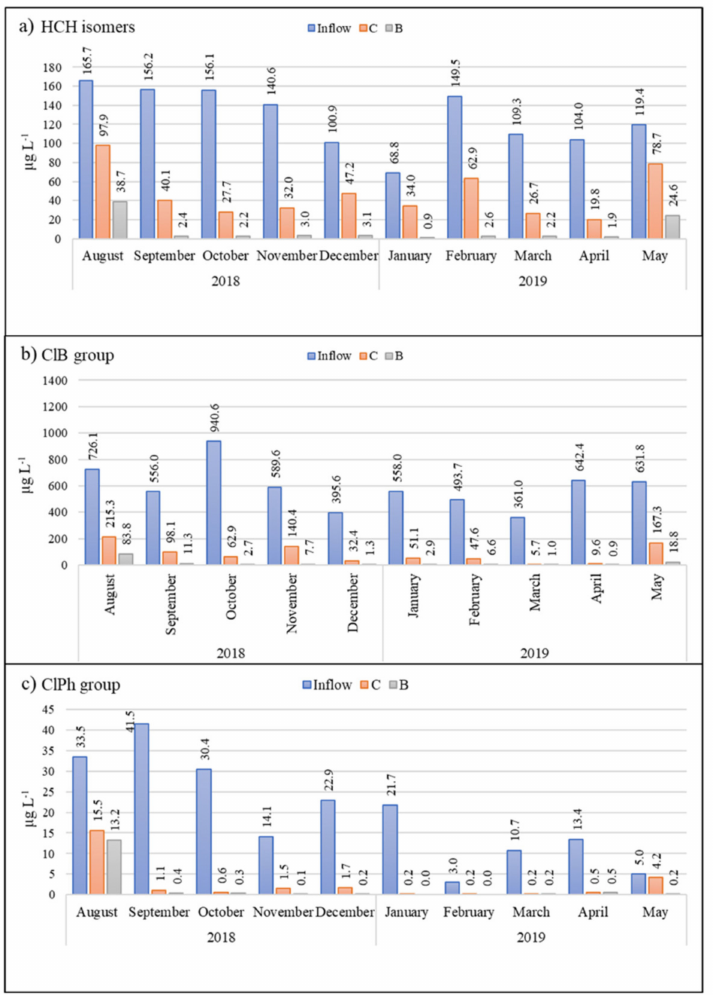
Figure 2. Monthly measurements of ( a ) HCH isomers ( b ) ClB, and ( c ) ClPh in polluted inflow water (blue), the control biofilter (C, orange), and the biochar biofilter (B, gray) over the course of the